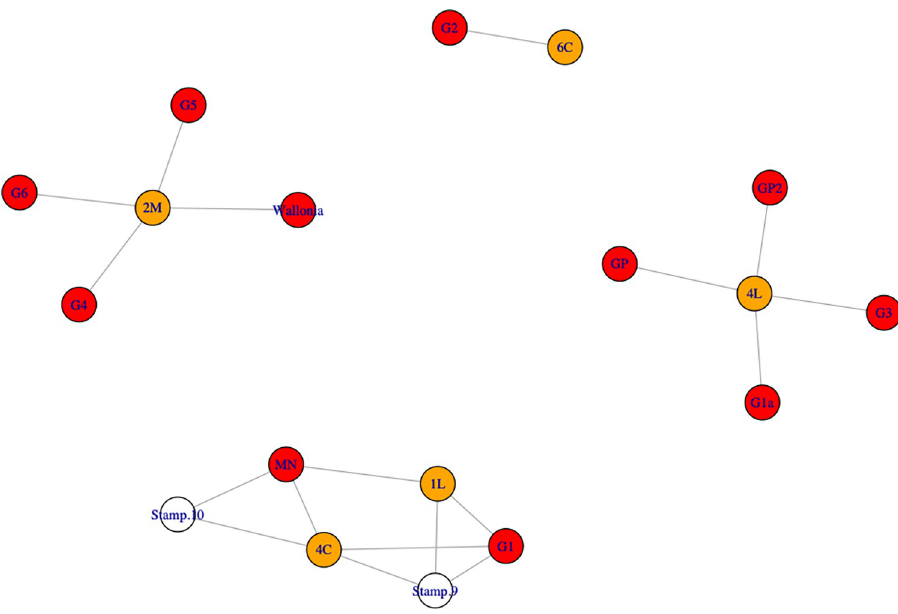
Fig 24. Network analysis (connecting lines indicate the same provenance) : P rovenance (in red) , bar type (in orange) and stamp (in white) . MN: Montagne Noire.